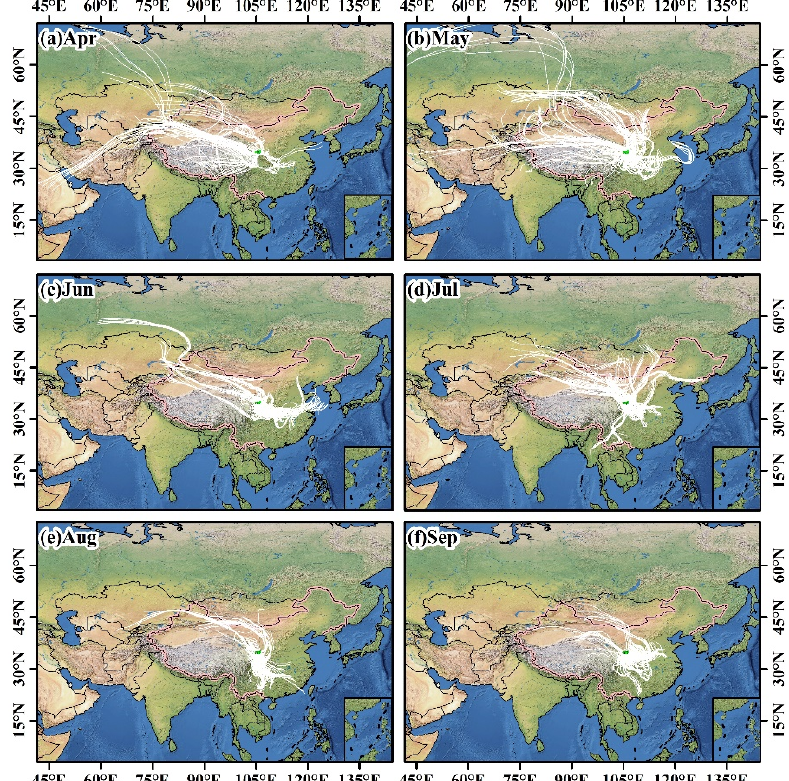
Figure 4. Back trajectories simulated by HYSPLIT model for the Tianshui area in April ( a ), May ( b ), June ( c ), July ( d ), August ( e ) and September 2019 ( f ). The white lines are the daily precipitation event vapor trajectories during the preceding five days (120 h) at 1500 m agl (above the ground level).